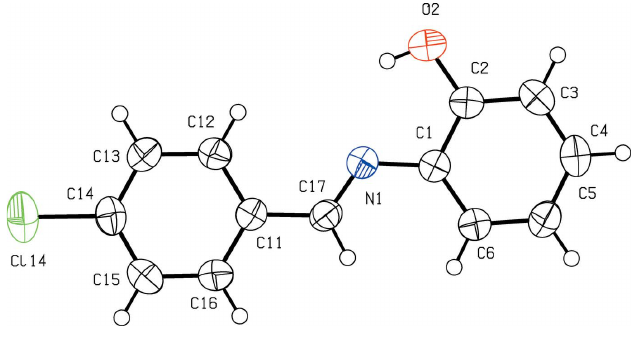
Figure 1 The molecular structure of compound (I), showing the atom-labelling scheme. Displacement ellipsoids are drawn at the 50% probability level.